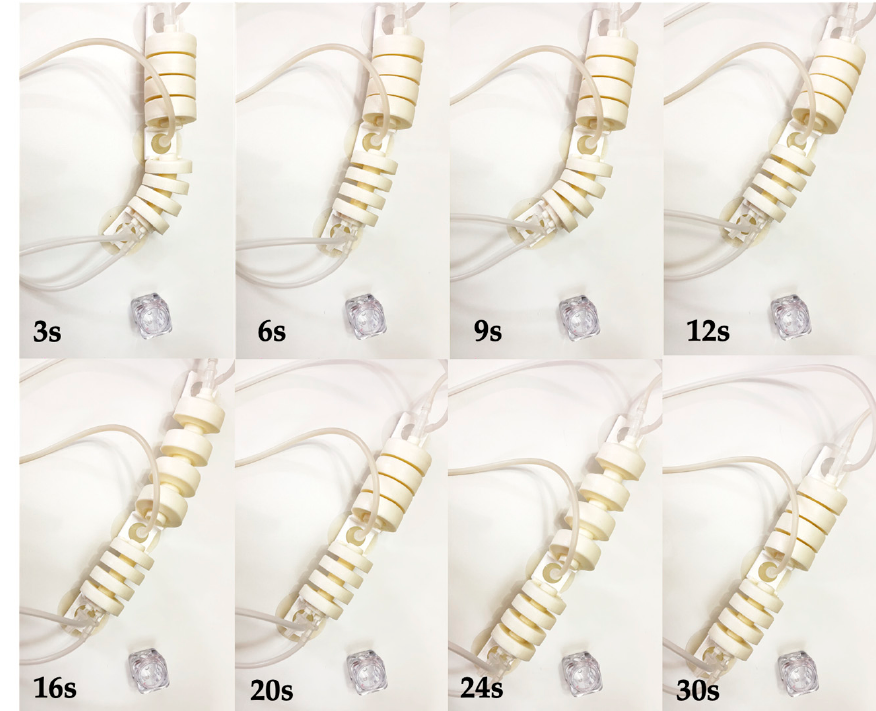
Figure 23. Obstacle avoidance testing of the robot.